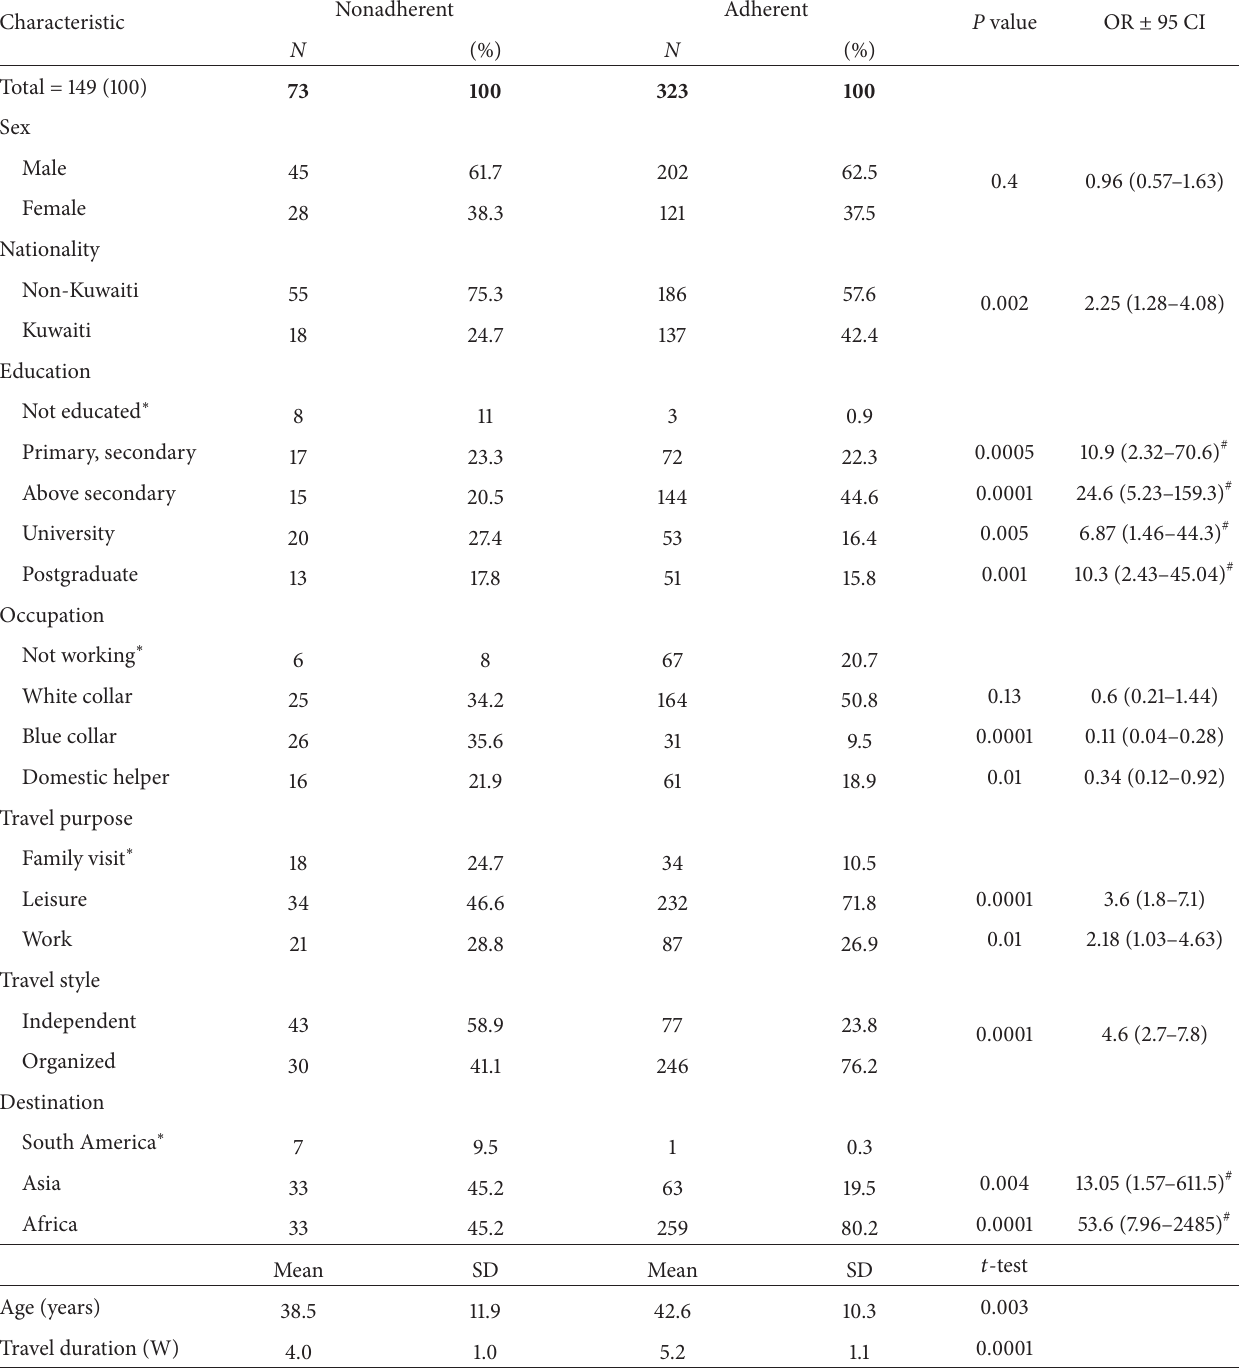
Table 3: Univariate analysis of mefloquine group between adherent and nonadherent